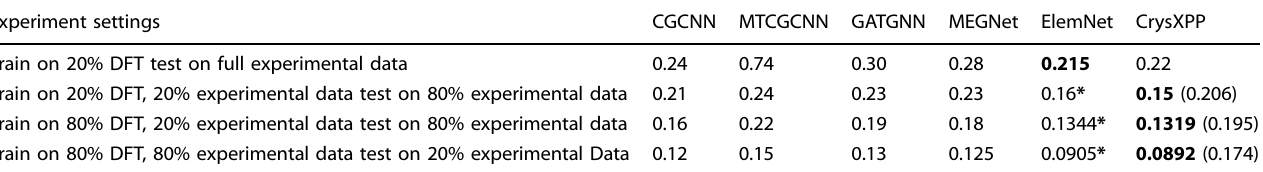
Table 3. MAE of predicting experimental values after fi ne tuning different methods with different percentages of experimental data for Formation Energy. MAE of the experiment where we replace the experimental data with the same amount of DFT data to train CrysXPP, is provided in the bracket. The closest prediction is marked in bold and second-best with * . Experiment settings